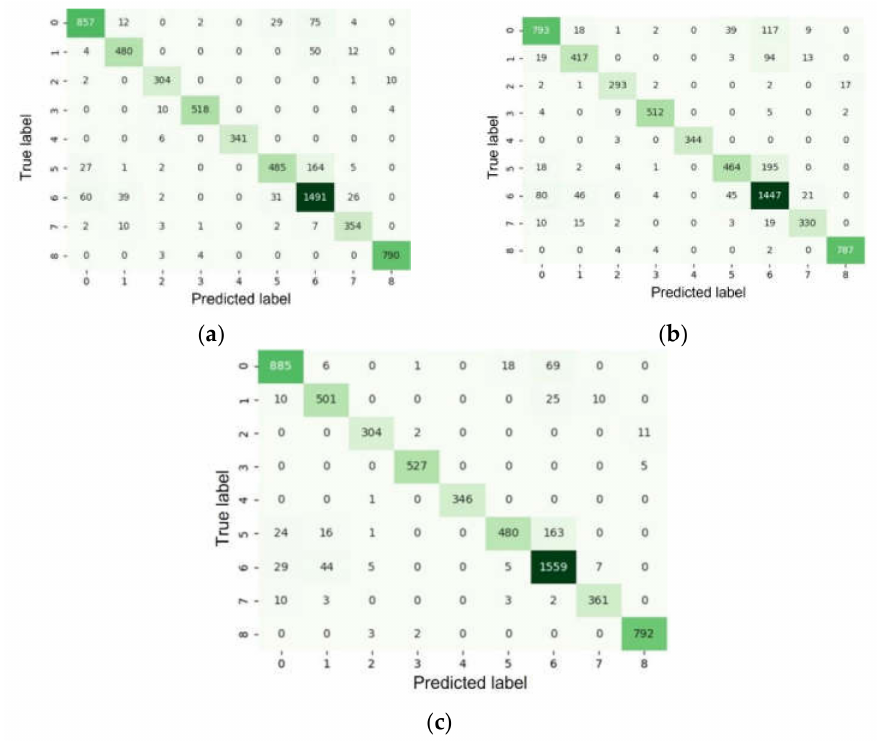
Figure 14. The confusion matrix obtained for the Indian Pines dataset with controlled sampling strategy based on the 3 × 3 (w3) window size for the training set, for N = 1 wavelet transform level